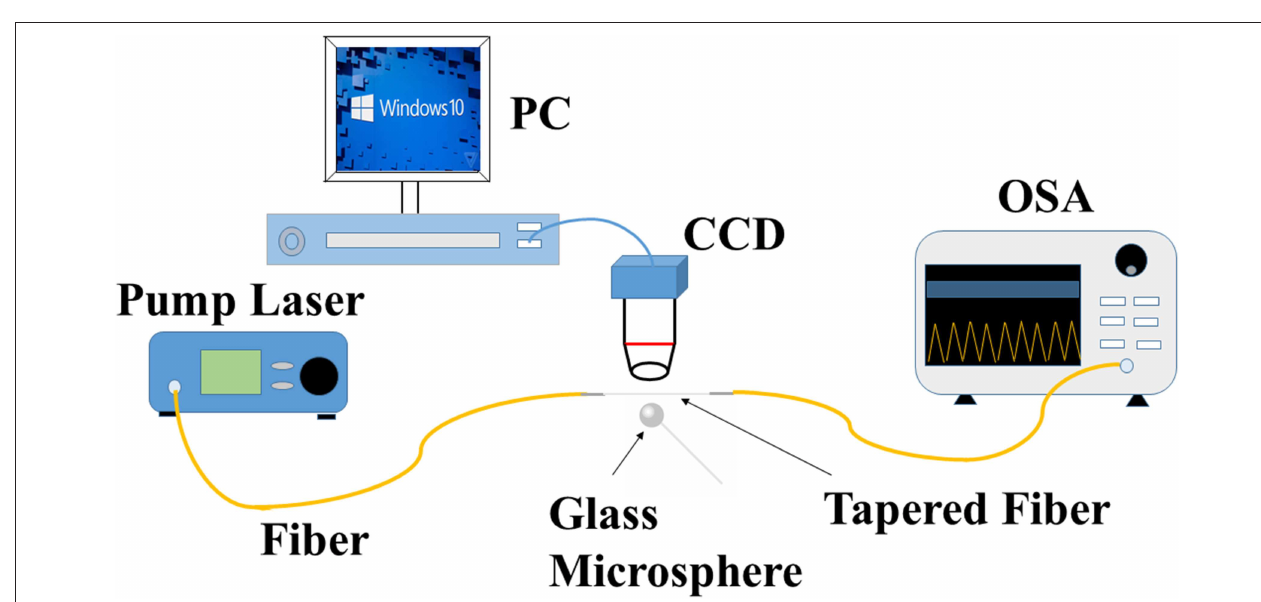
FIGURE 4 | Diagram of the experimental set-up used to characterize the Nd 3 + doped fluorosilicate glass microsphere laser.